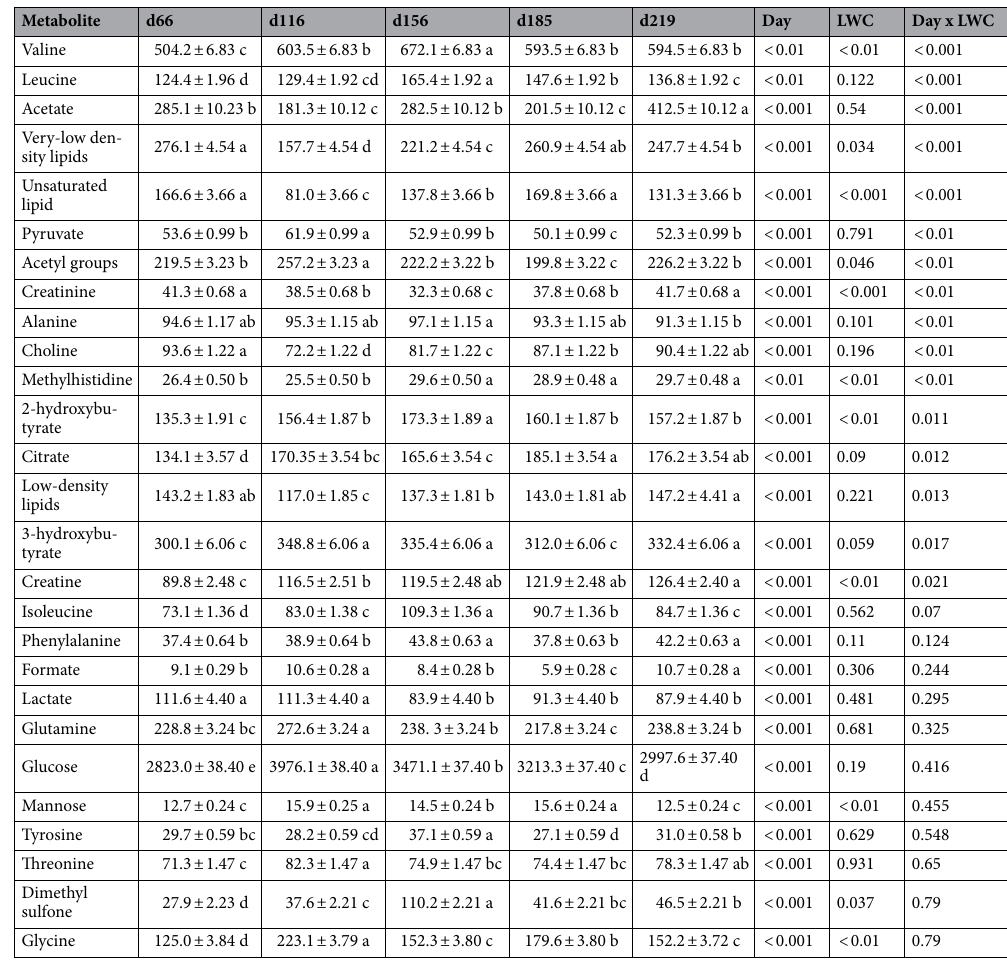
Table 1. Relative abundance of blood metabolites on five sampling points of grazing beef cattle and the P -values for factors in the statistical model blood sampling day (Day), live weight change (LWC) as a covariate, and their interactions. a,b,c,d,e Means within rows without a common superscript